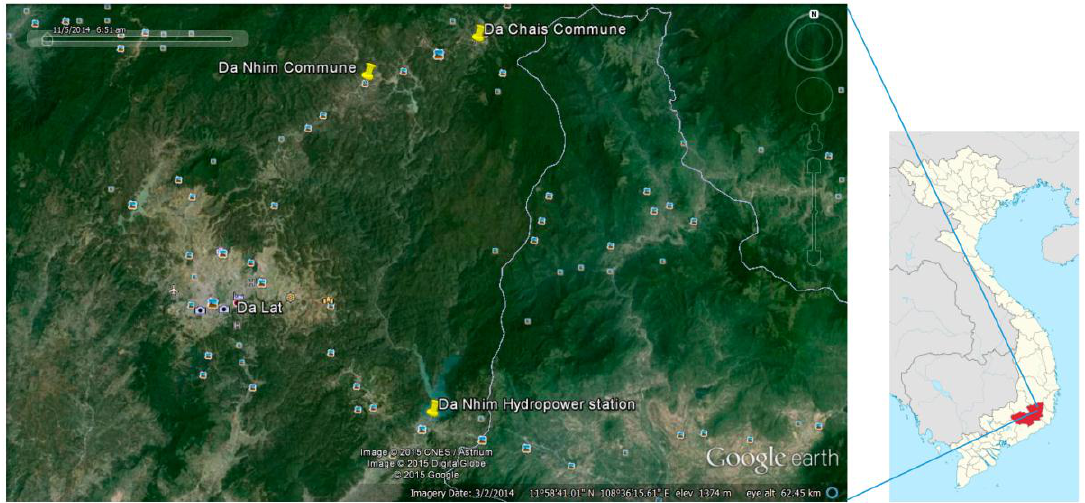
Figure 1. Study sites of Da Nhim and Da Chais, Lam Dong Province, Vietnam, 2016. Maps generated from Google Earth and Wikipedia [28].